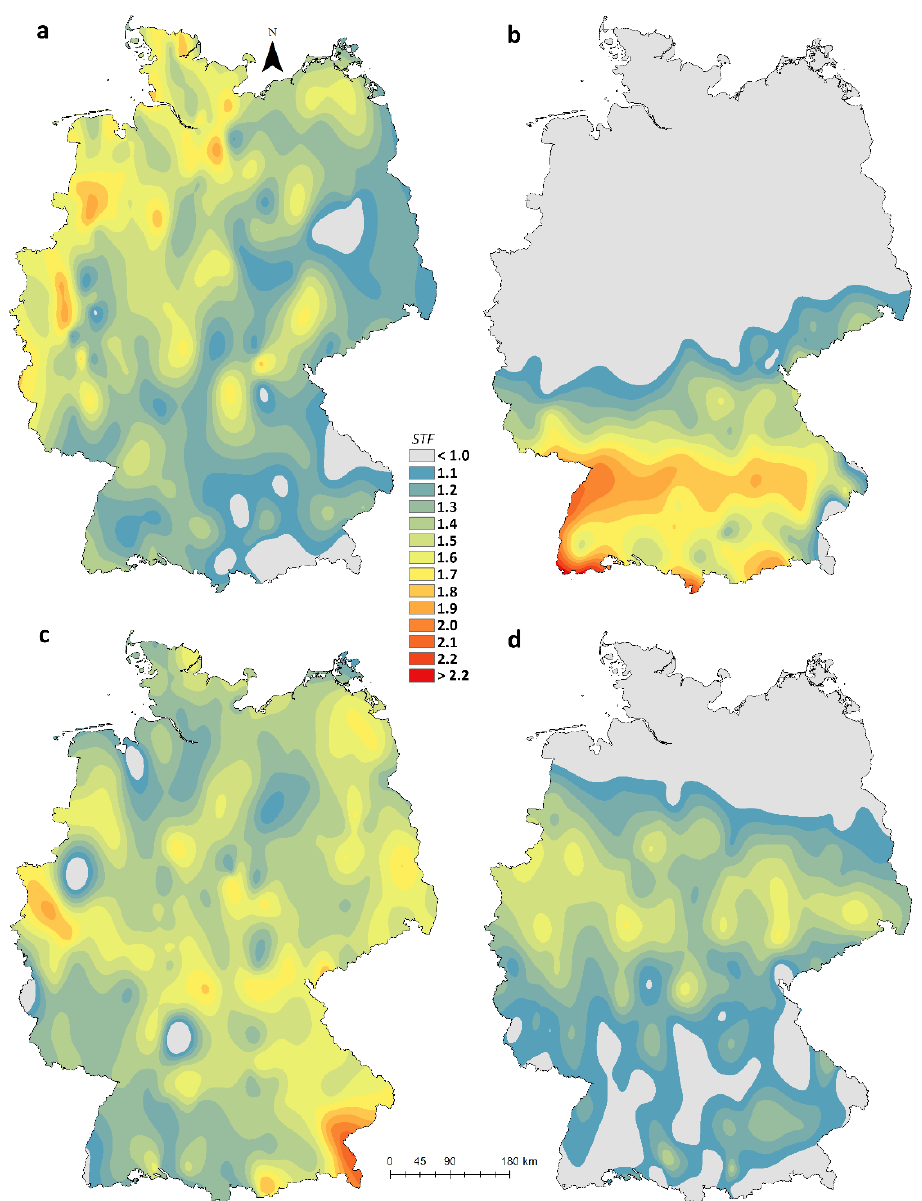
Figure 5. Storm field factor ( STF ) of the winter storms ( a ) Daria; ( b ) Lothar; ( c ) Kyrill and ( d ) Friederike. 221